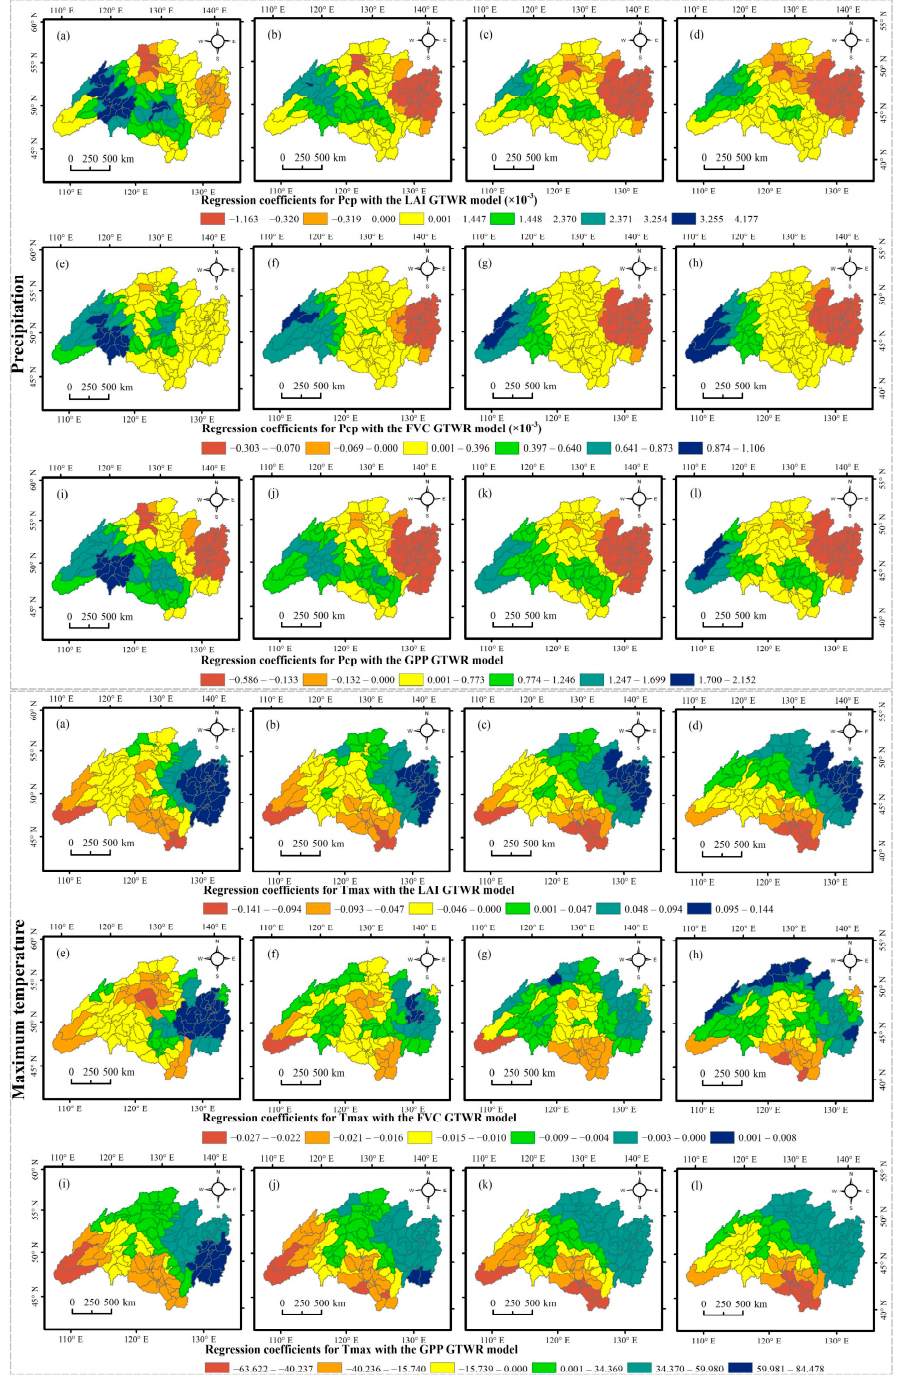
Figure 6. The spatial distribution of the regression coefficients for Pcp and Tmax with the LAI (( a – d ) present the coefficients for Periods 1–4, respectively), FVC (( e – h ) show the coefficients for Periods 1–4, respectively), and GPP (( i – l ) exhibit the coefficients for Periods 1–4, respectively) GTWR models for four studied periods.